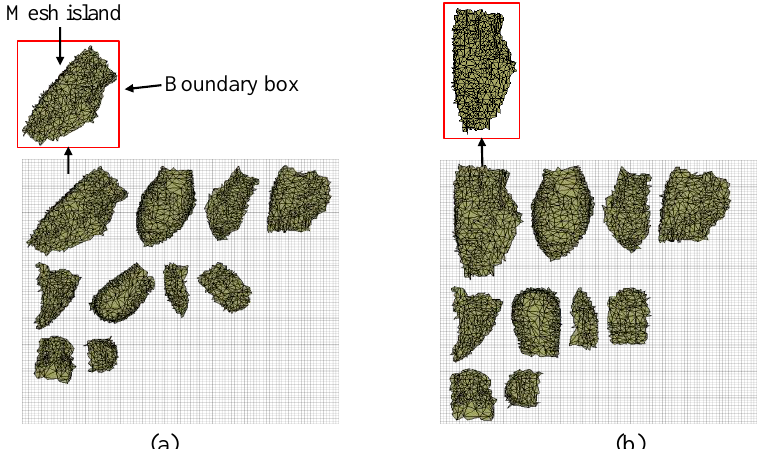
Figure 11. The results of mesh-island packing for two methods: ( a ) AABB method and ( b ) OBB method.